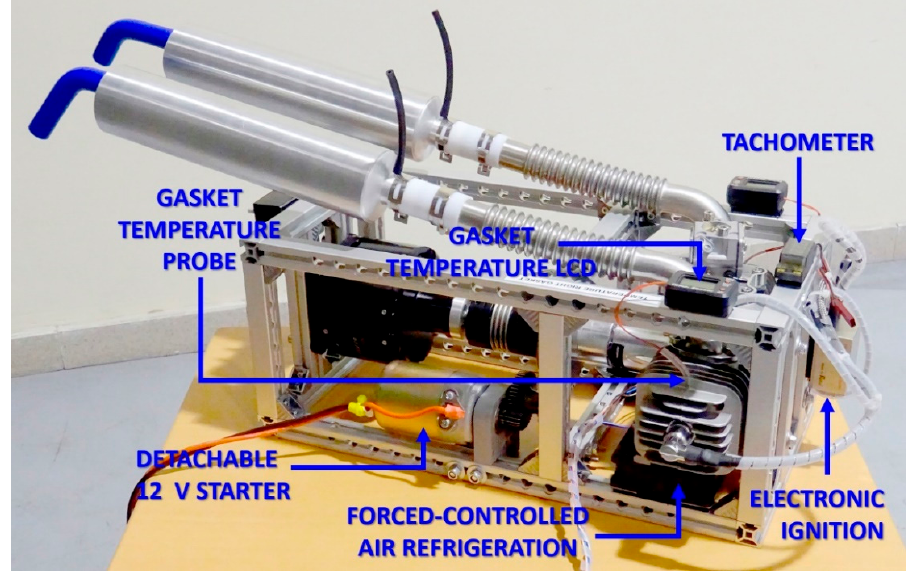
Figure 25. Global view of the prototype.